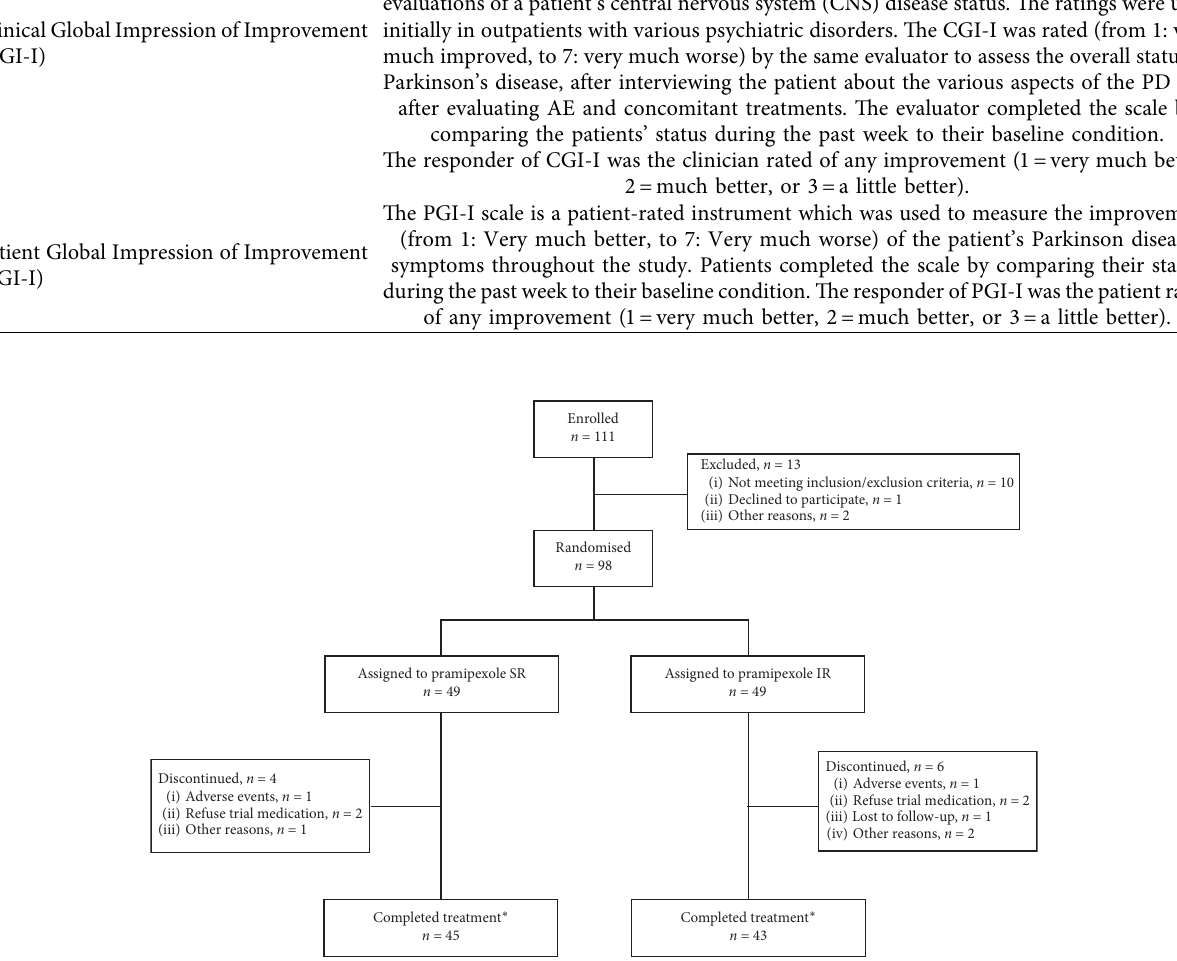
Figure 1: Flow chart: enrolment, treatment allocation, and completion of study participants. ∗ Completed titration/maintenance. IR, immediate release; SR, sustained